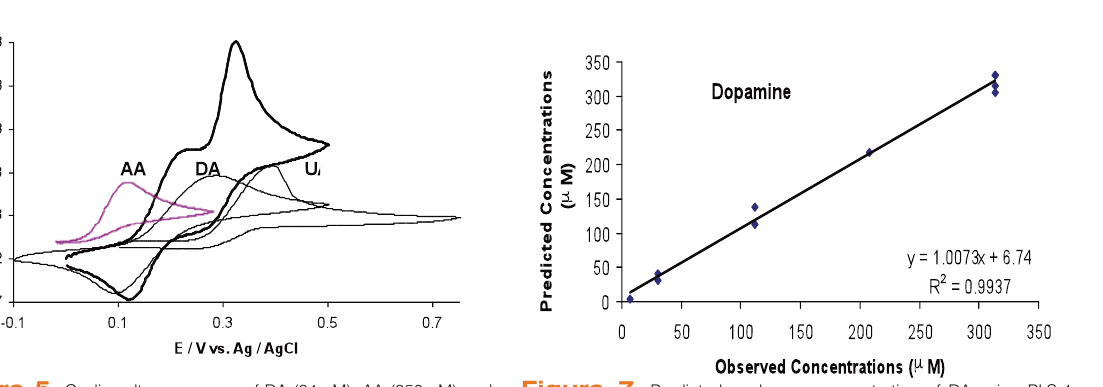
Figure 7. Predicted vs. known concentration of DA using PLS-1 model with 5 components.